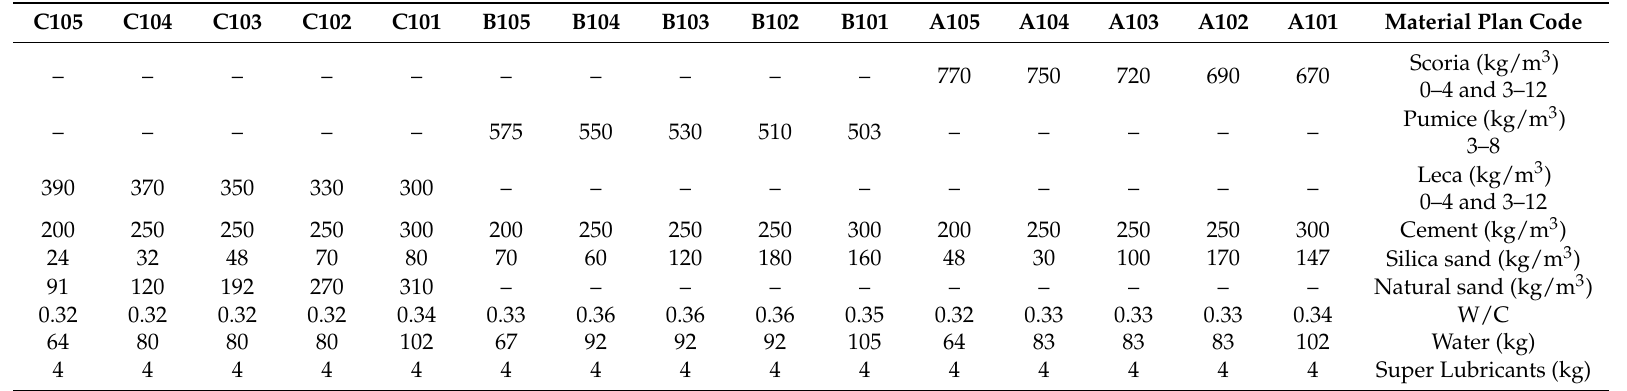
Table 10. Mix of natural and artificial lightweight aggregate